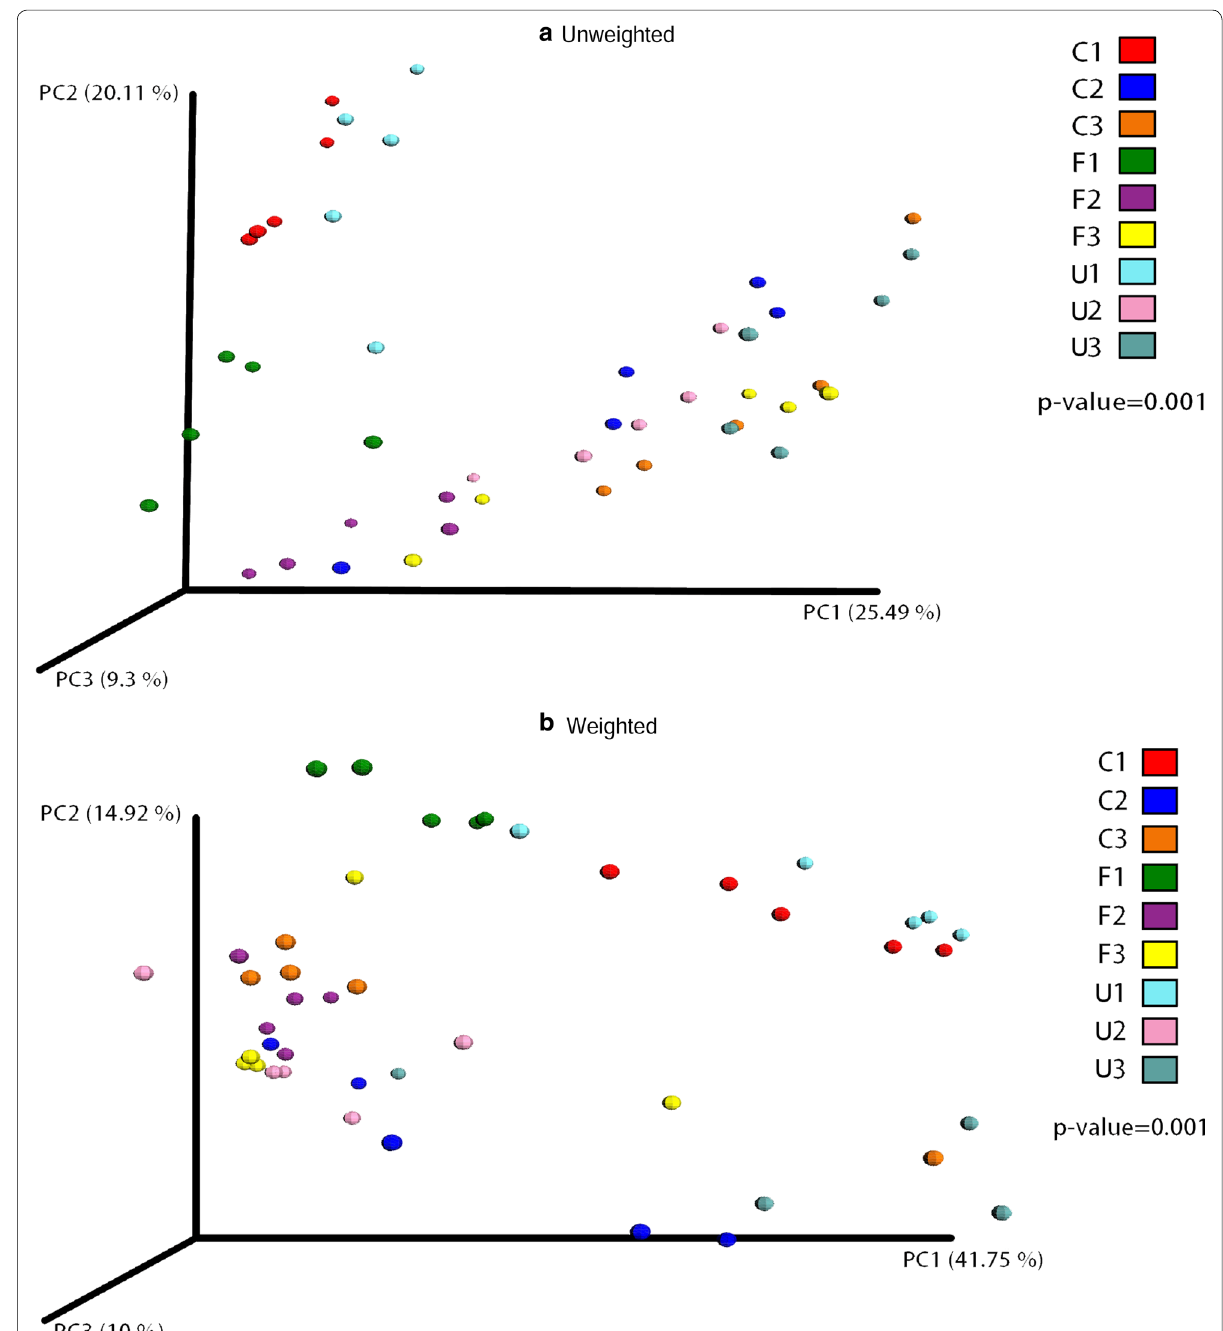
Fig. 1 Beta diversity analysis of the 45 fecal samples. a Unweighted and b weighted UniFrac PCoA of individual chickens in each group. Individual samples are represented as group C (C1 on day 7, C2 on day 21, and C3 on day 35), group U (U1 on day 7, U2 on day 21, and U3 on day 35), and group F (F1 on day 7, F2 on day 21, and F3 on day